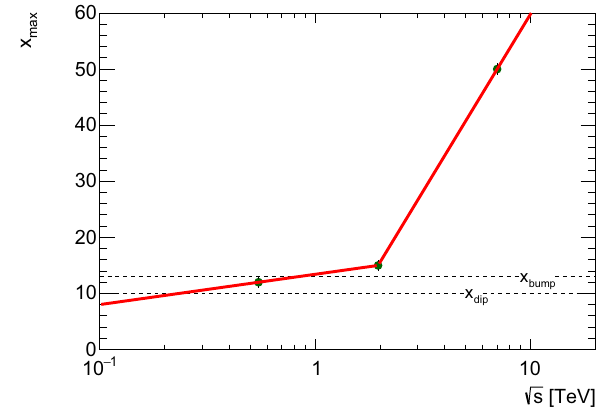
Fig. 13 Thecalculatedupperlimitofthe s -dependentdomainofvalid- ity of the H ( x ) scaling, x max ( s ) , is indicated by the dots and their corresponding error bars. Their s -dependent extrapolation, linear in ln ( s ) is also shown, while the points are determined assuming that √ H ( x , s ) = H ( x , s 0 ) with s 0 = 7 TeV, and comparing the result- ing differential cross-sections from the H ( x ) scaling limit of the ReBB model of Ref. [42] with the validated s -dependent calculations that include scaling violations, too. If the H ( x ) scaling is valid, the dip position x dip ≈ 10 and the position of the diffractive maximum or bump, x bump ≈ 13 are independent of s , as indicated on the same